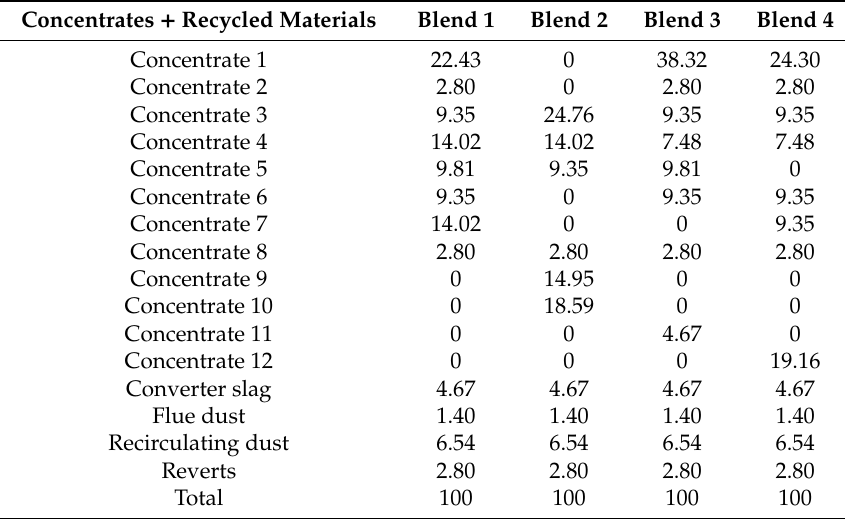
Table 7. Components of each blend studied for this work (wt.%).